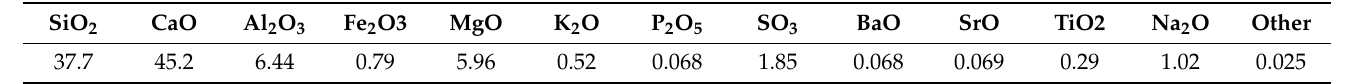
Table 1. The XRF analysis showing the chemical composition of the slag, wt%.